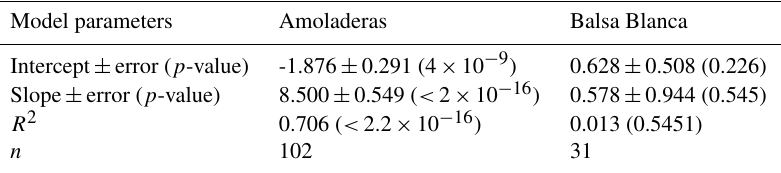
Table 3. Linear regression results between half-hourly net CO 2 fluxes of maximum quality (QC flag = 0) and friction velocity ( u ∗ ) used to model subterranean